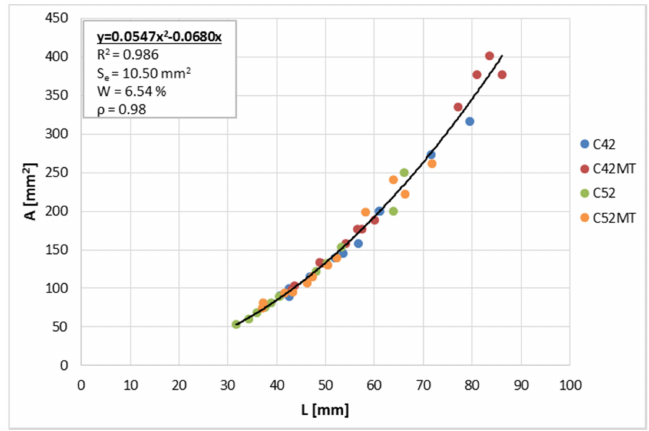
Figure 7. The average cluster area A in function of the average cluster perimeter L ; R 2 —the coefficient of determination; S e —the standard error of estimation; W —the random variation coefficient; ρ —the correlation coefficient.